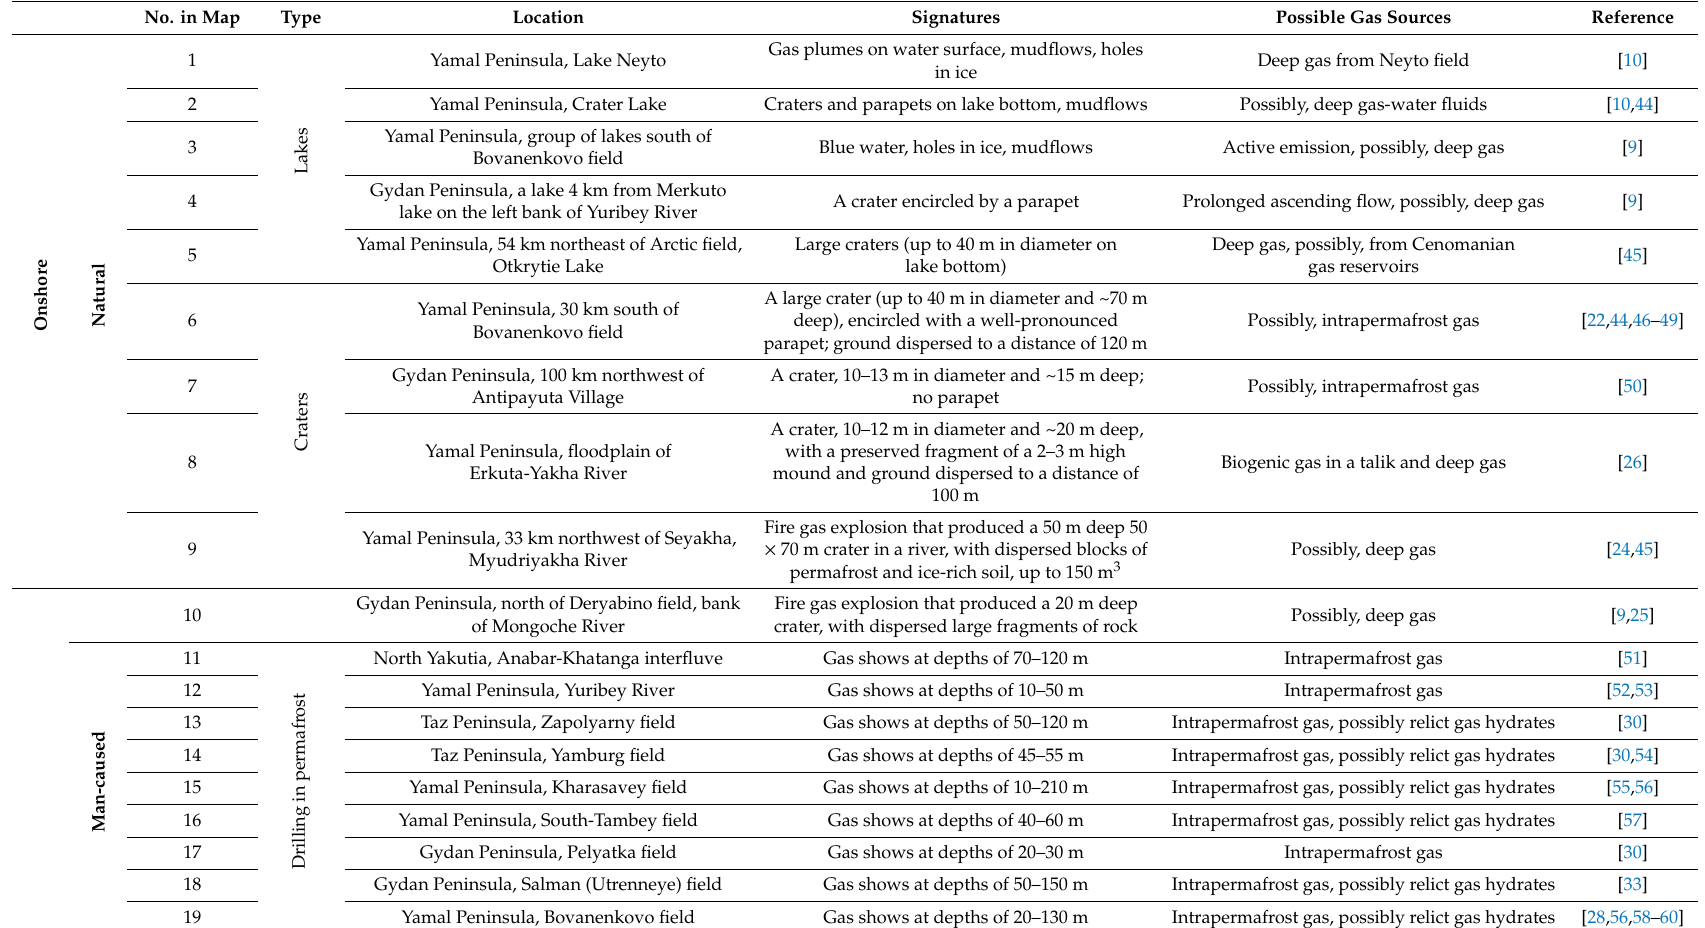
Table 1. Known gas emission sites in the Russian